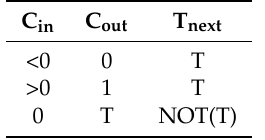
Table 1. Truth table of quantizer utilized by counter based